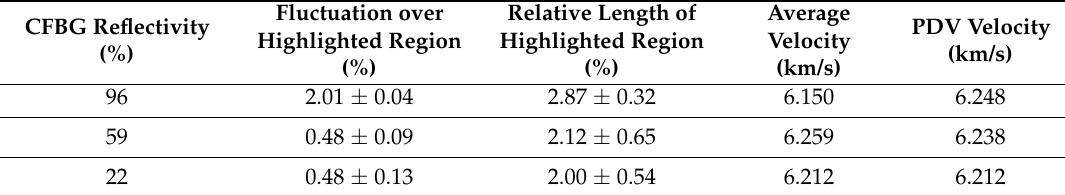
Figure 12. Graphs showing the calibrated and low-pass filtered (20 MHz) data from three 20 nm CFBG tests with: ( a ) 96% reflectivity; ( b ) 59% reflectivity; and ( c ) 22% reflectivity. Each CFBG is approximately 120 mm long. Plotted underneath are the residuals from the linear regression. The non-linear region, highlighted in green, is most prominent in the 96% reflectivity CFBG. Table 1. The properties of the non-linear region for different reflectivity (96%, 59%, and 22%), 20 nm bandwidth CFBG